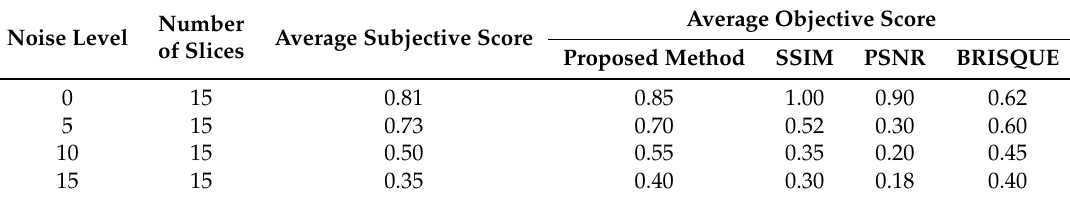
Table 2. Comparative Performance Evaluation of the Proposed Method with SSIM, PSNR and BRISQUE Quality Metrics using T1 MRI